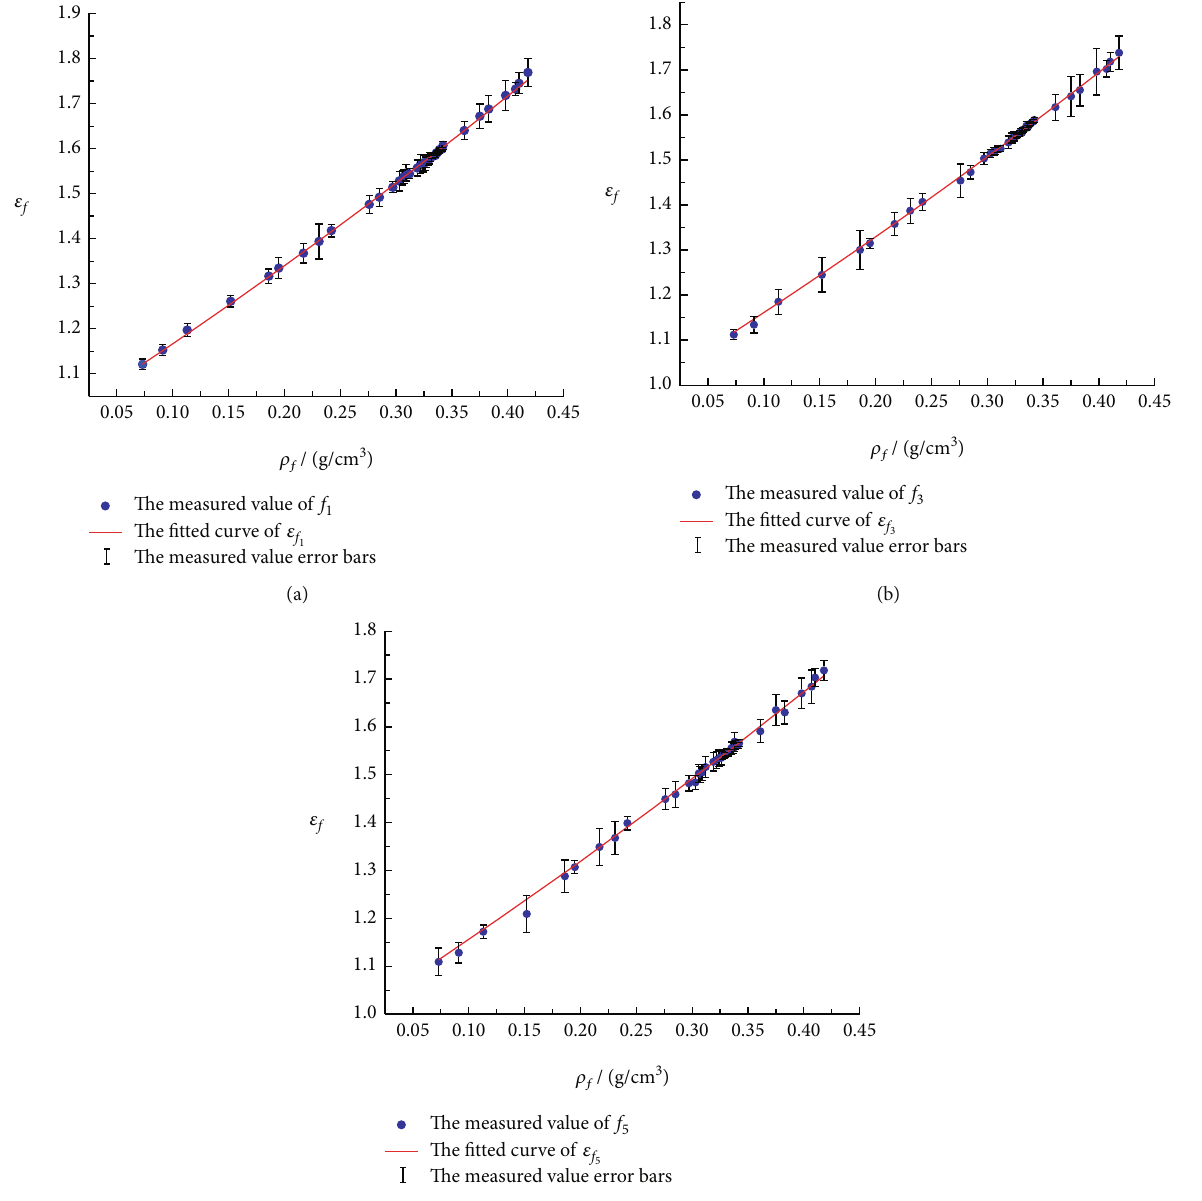
Figure 7: Relationship between dielectric permittivity and density at three frequencies. (a) f 5010MHz